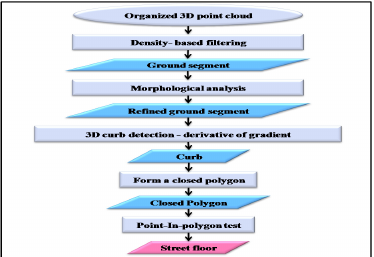
Figure 4. Street floor extraction